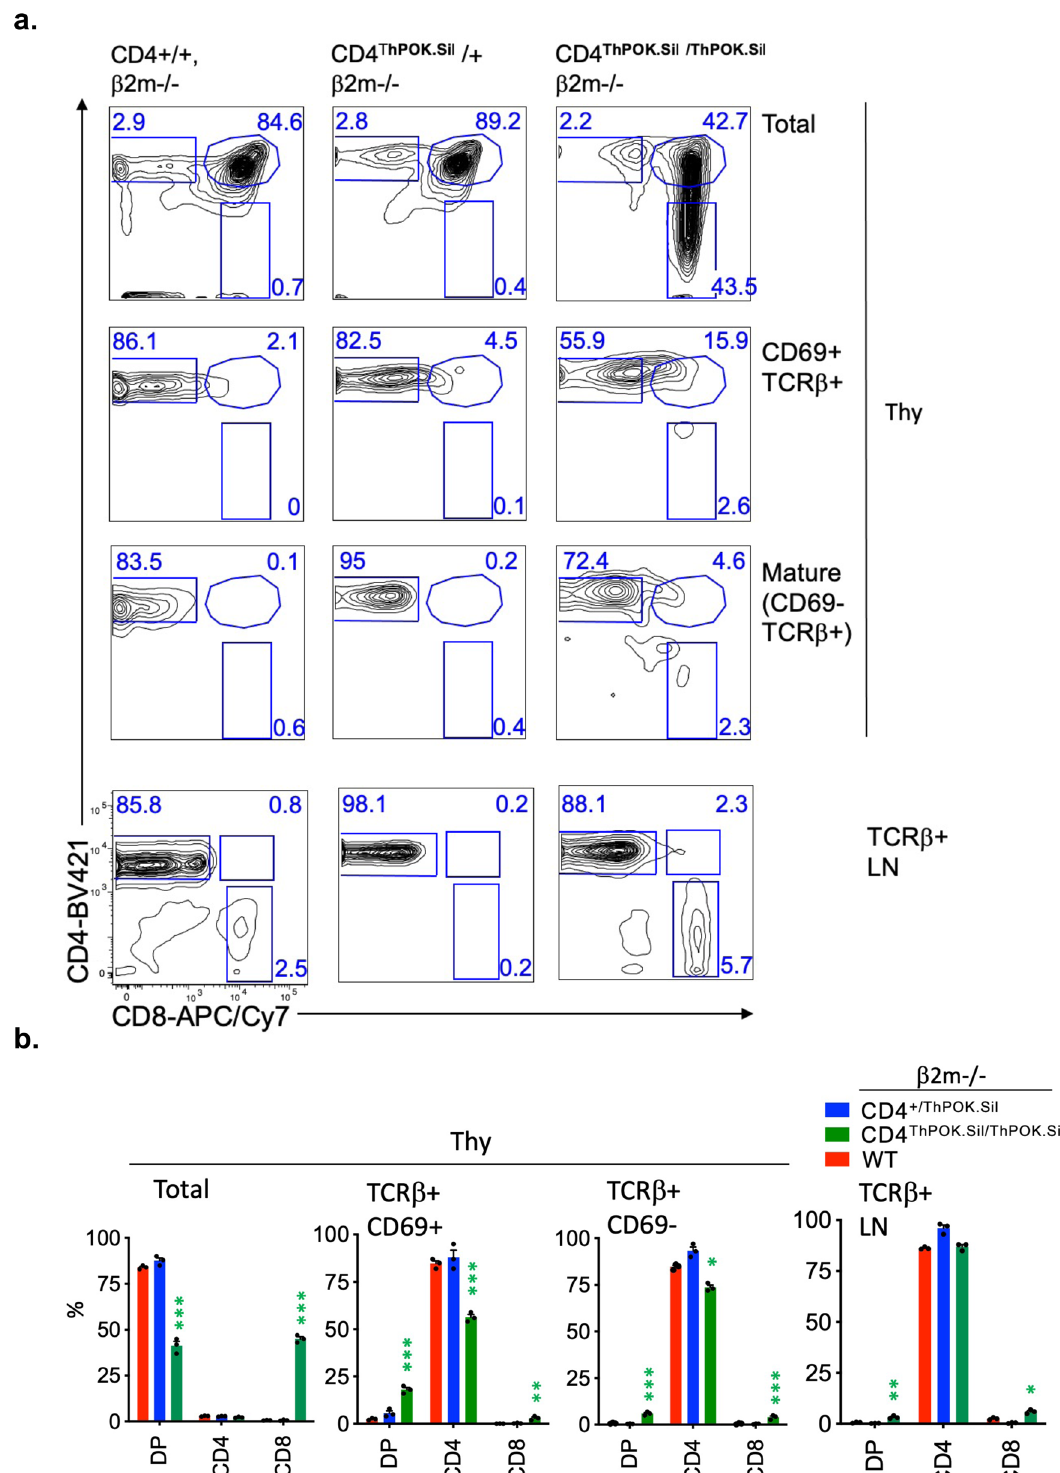
Fig. 2 Sil ThPOK causes partial redirection of MHC class II-restricted thymocytes to CD8 lineage in CD4 ThPOK.Sil knock-in mice. a FACS analysis of CD4 and CD8a expression by indicated thymic or peripheral lymphocyte populations of wt, CD4 ThPOK.Sil/ + or CD4 ThPOK.Sil/ThPOK.Sil mice crossed to the β 2 m- de fi cient background. b Plots showing % of DP, SP CD4, and SP CD8 thymocytes and LN for mice of indicated strains on β 2m − / − background. N = 3 independent animals, for each strain. Data are presented as mean values + / − SEM. A P value < 0.05 was considered signi fi cant. Signi fi cant differences between indicated mutant mice and WT mice were determined by one-way ANOVA with post hoc Tukey HSD (honest signi fi cant difference), and indicated by asterisks (* P < 0.01; ** P < 0.005; *** P < 0.001). Statistical signi fi cance was calculated for each indicated mutant line relative to β 2m − / −